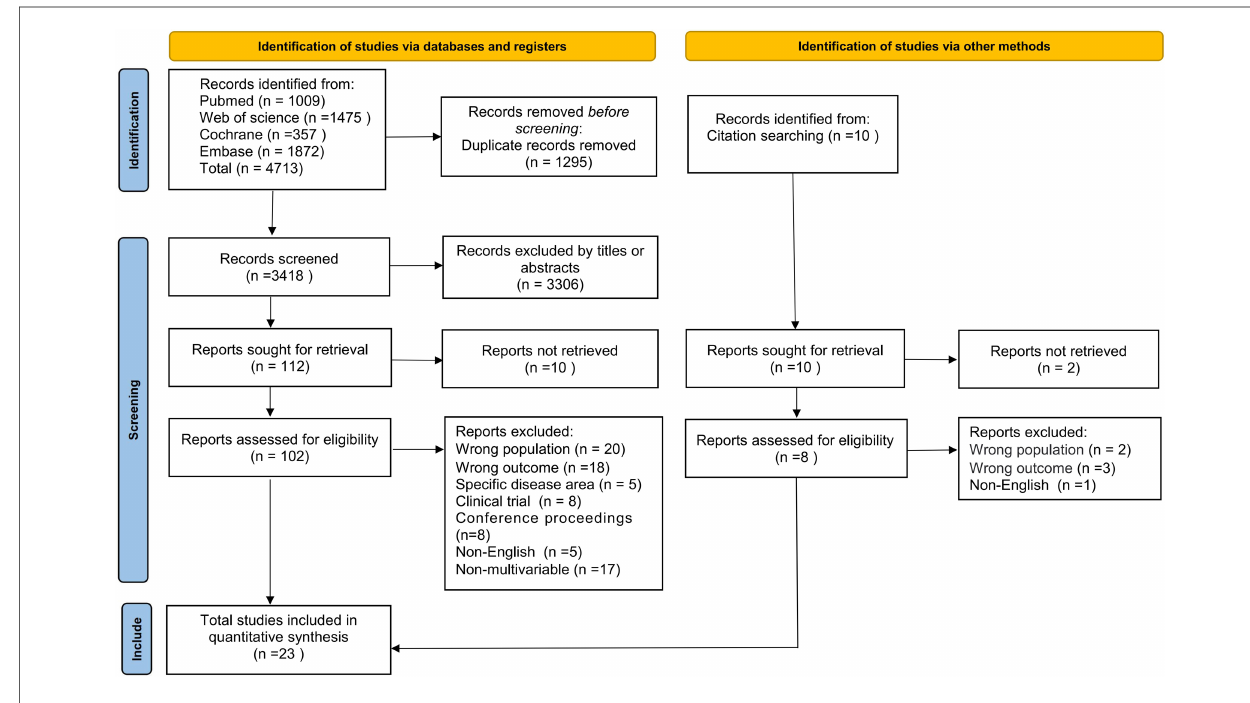
FIGURE 1 Flow chart of the systematic literature